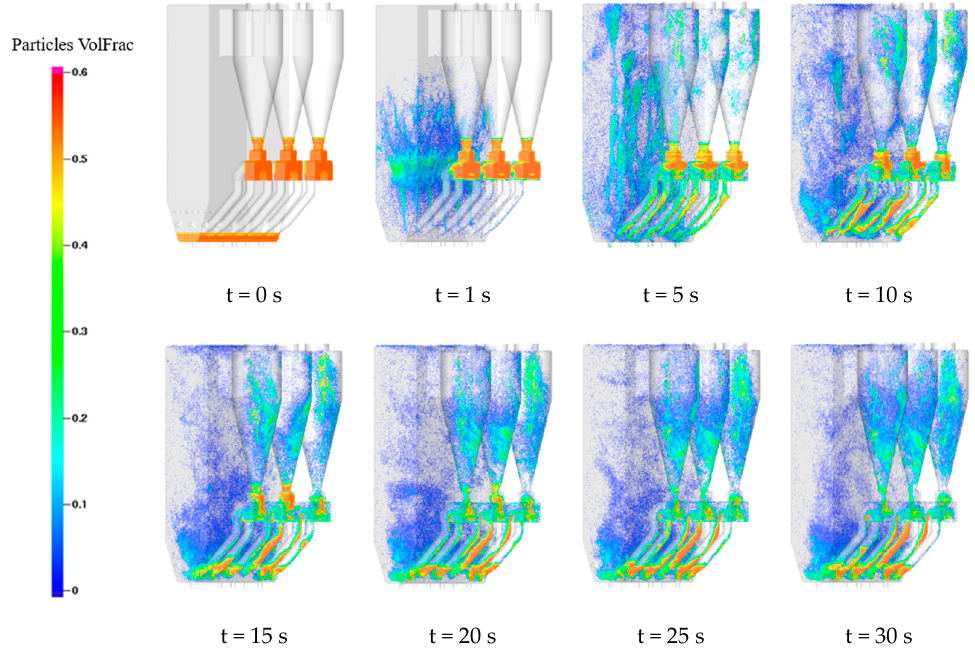
Figure 19. Gas-solid flow changes of the whole circuit of the CFB boiler (0~30s).